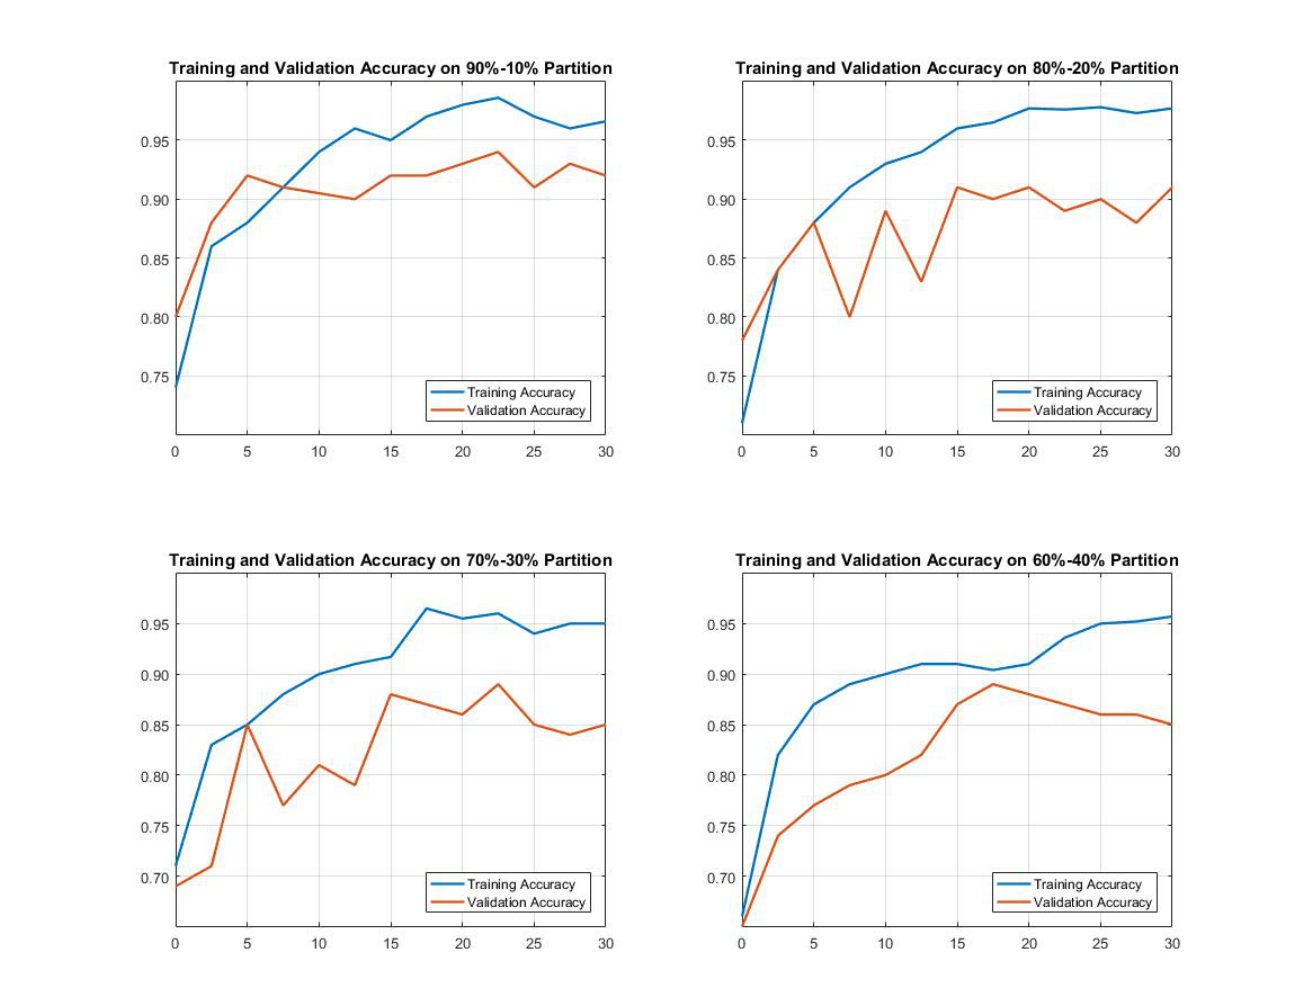
Figure 12. Training and validation accuracy for CNN by taking different combination of data